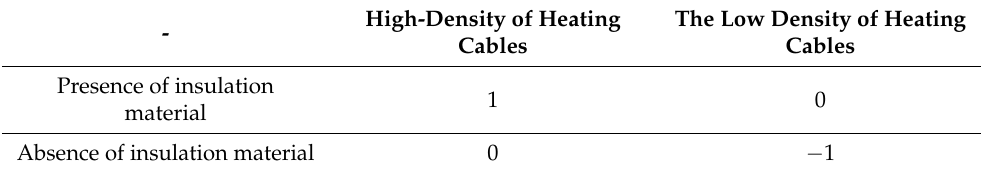
Table 1. A program that returns a value according to the density of heating cables.